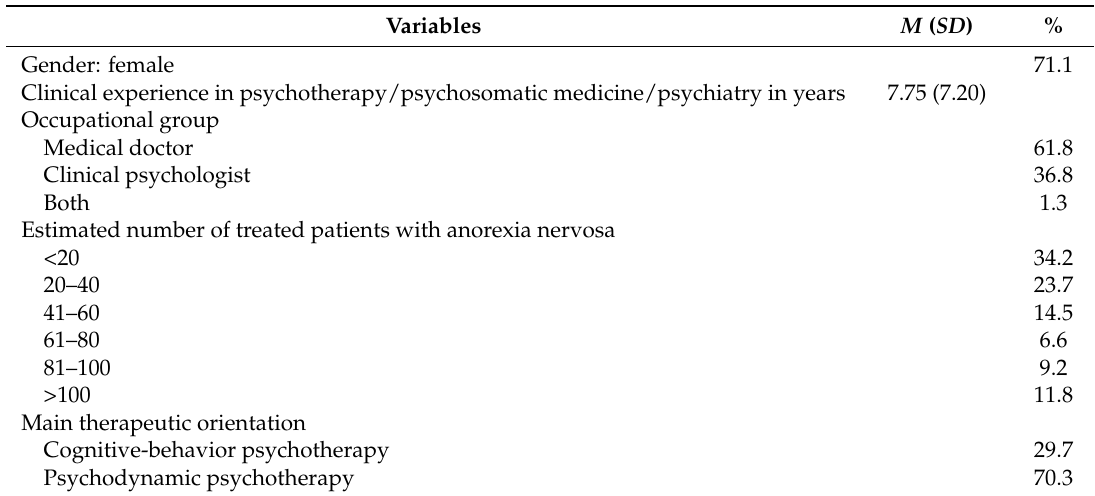
Table 1. Demographic characteristics of the study sample ( n =